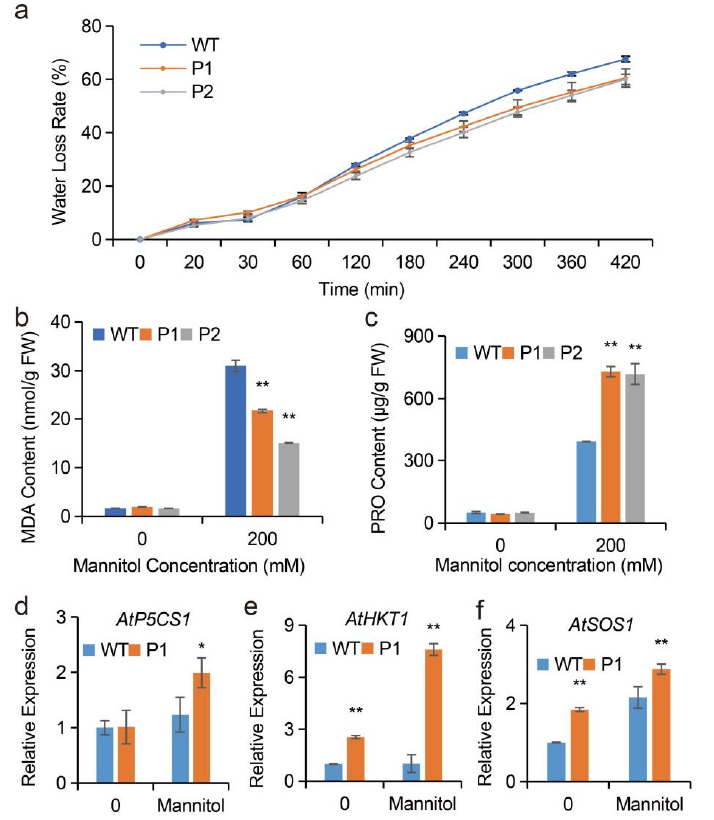
Figure 8. Analysis of water lose rate, MDA and PRO contents and stress-related genes under 0 or 200mM mannitol treatment. ( a ) The water lose rate. ( b ) The MDA content. ( c ) The PRO content. Expression levels of AtP5CS1 ( d ), AtHKT ( e ) and AtSOS1 ( f ) in WT and P1. (* p < 0.05, ** p < 0.01, one way ANOVA).